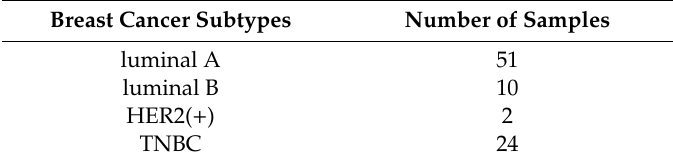
Table 6. The numbers of distinct breast cancer subtypes on test data.